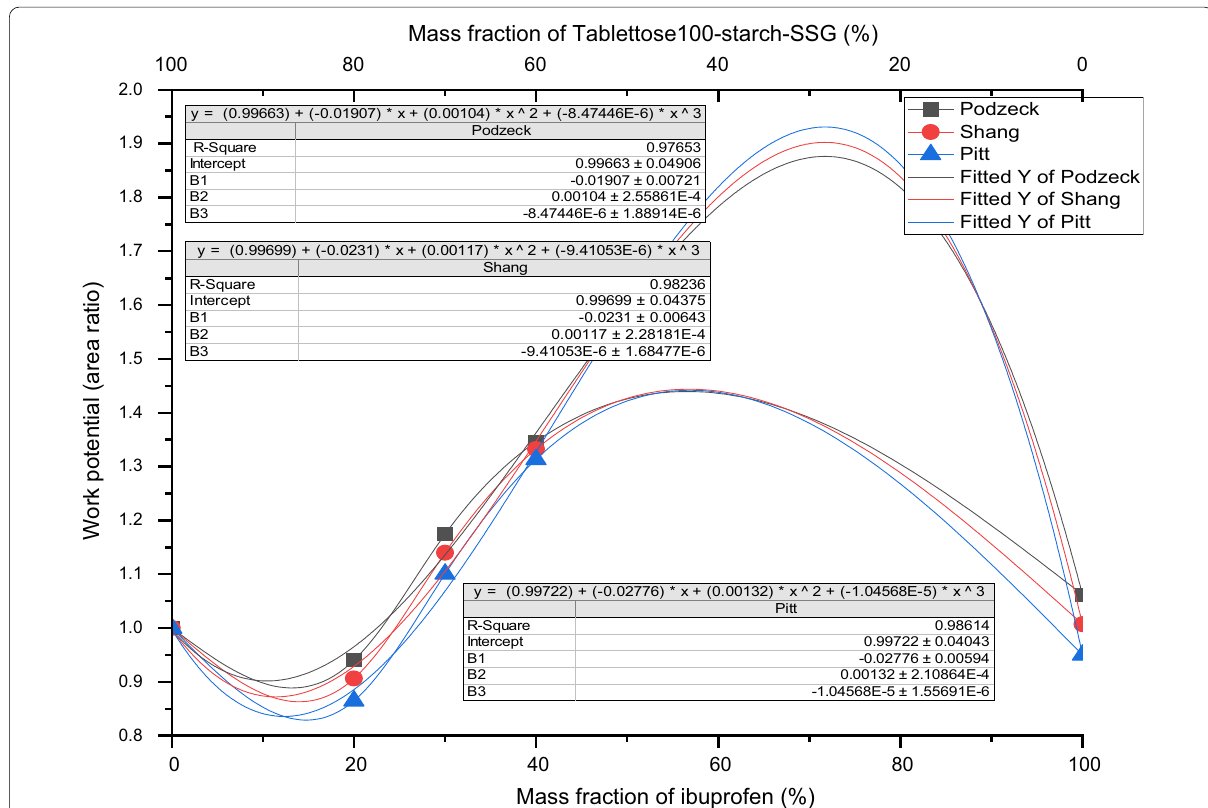
Fig. 8 Third-order polynomial fitting of area ratio-mass fraction data using orodispersible α-lactose-starch diluent was the model diluent